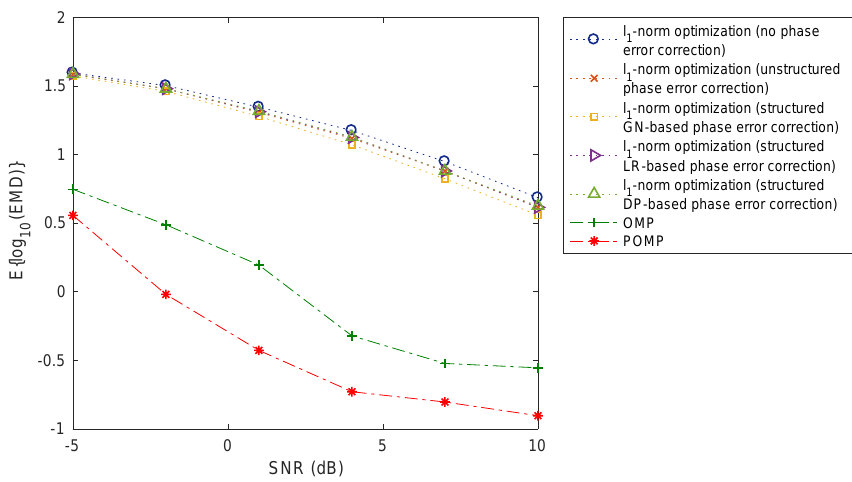
Figure 7. Earth mover’s distance (EMD) performance of the OMP, POMP, and l 1 -norm regularised optimisation methods versus various of SNRs ( ∆ R 2 = 2.78 ∆ Grid